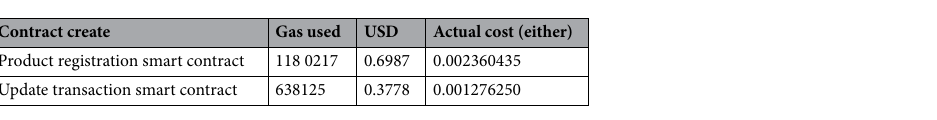
Table 1. Smart contract